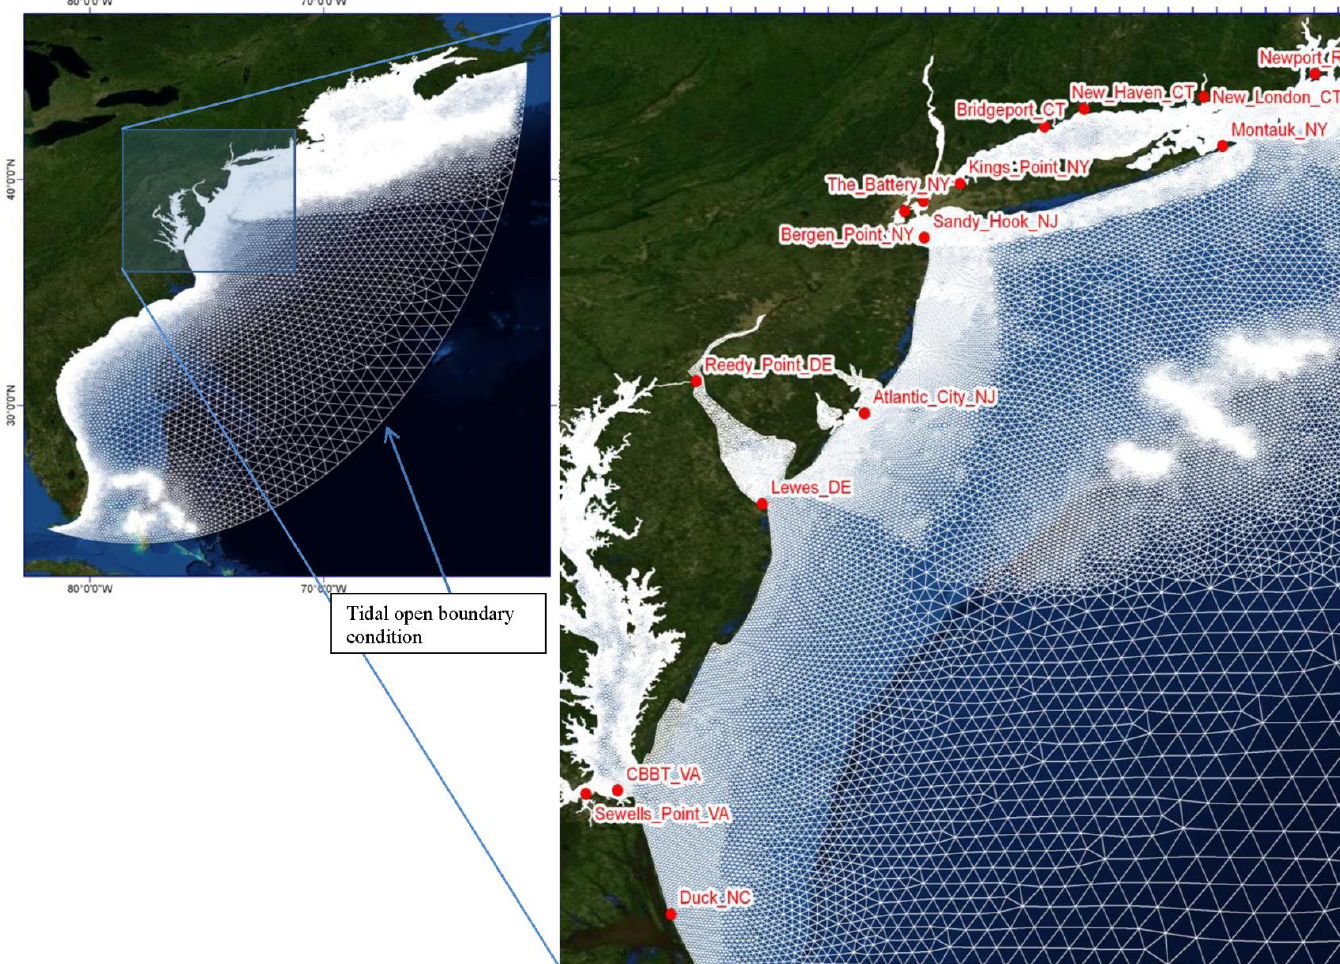
Figure 1. The Semi-implicit Eulerian Lagrangian Finite Element (SELFE) storm tide model domain covering the US East Coast from Key West to Nova Scotia at 62°W (left panel). The inset of the mid-Atlantic Bight portion of the US East coast with the NOAA tidal gauge stations used for model and data comparisons (right panel). Global tidal constituents were specified at the open